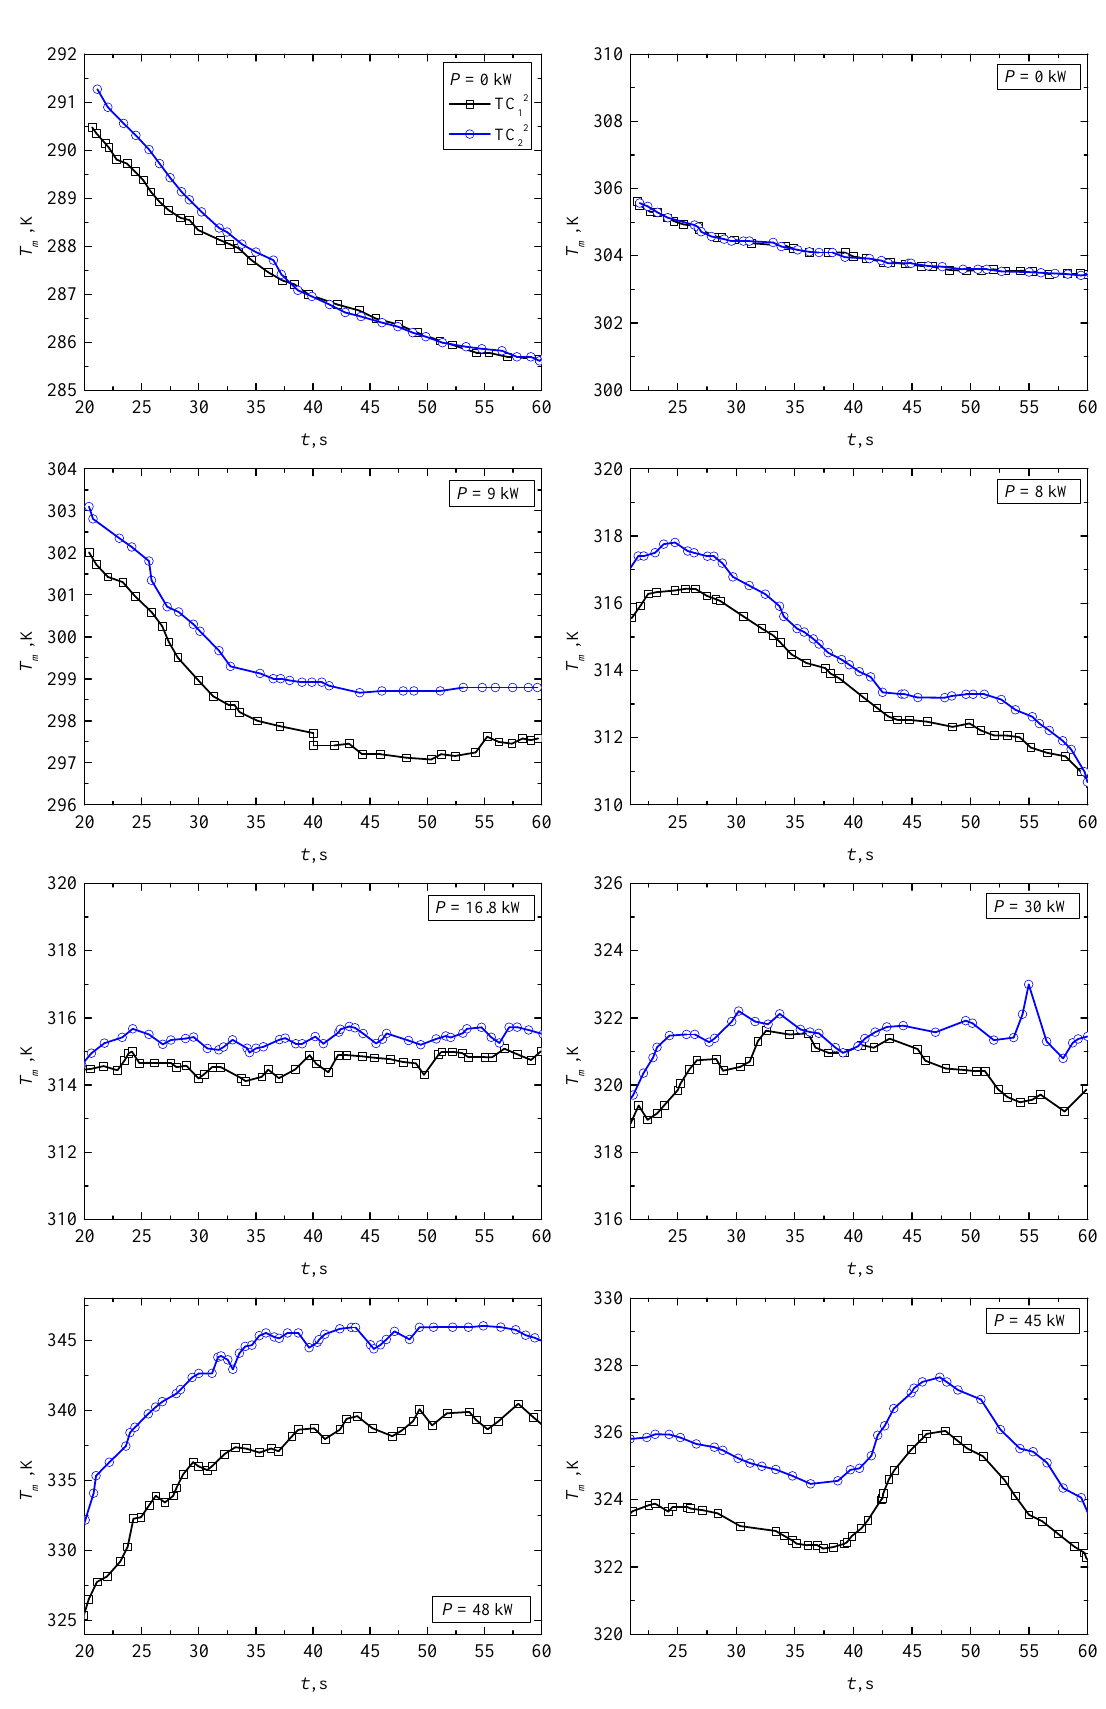
Figure 7. Mould wall temperature variations at different P at h = 0.076 m for trial A ( left ) and trial B ( right